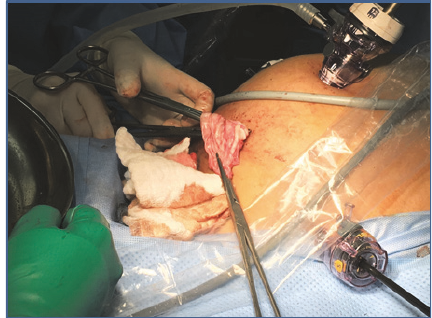
Figure 2: The cyst wall components removed through suprapubic opening.